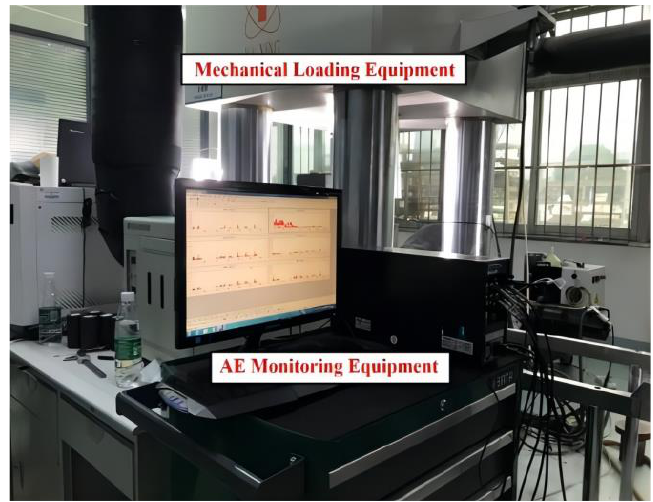
Figure 2. Mechanical loading equipment and AE system.